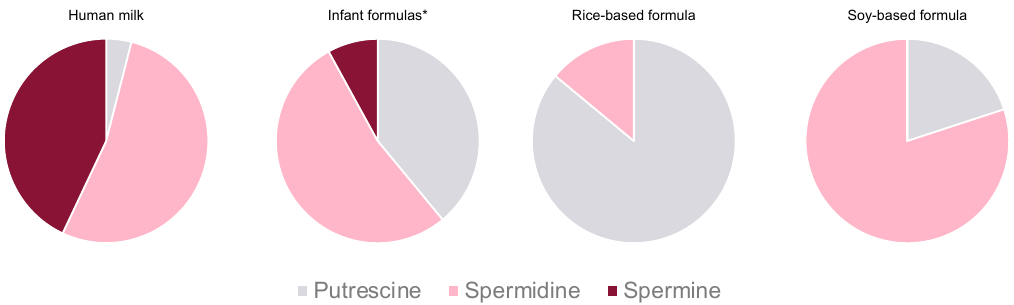
Figure 3. Polyamine distribution in human milk and infant formulas. * First, follow-on and preterm infant formulas.